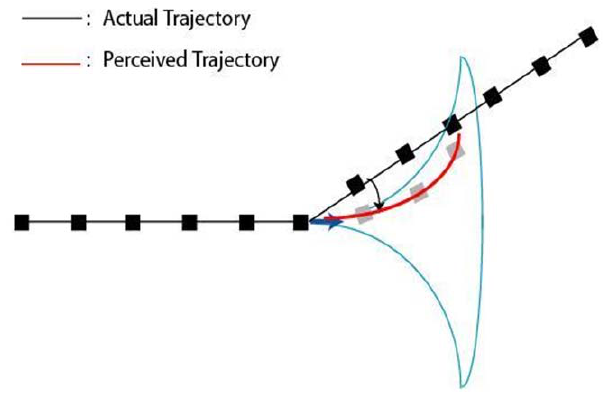
Figure 1. The proposed effect of motion-anticipation on the perceived trajectory. The black squares represent a path of apparent motion and the moving dot deviates from horizontal motion (black line). The motion-anticipation (cone), shifts the perceived positions of the dot resulting in the trajectory shown by the gray dots. The shifts in the perceived positions of the dot causes a curvature in its perceived trajectory (red curve), resulting in smoothing for deviations that are smaller than 90